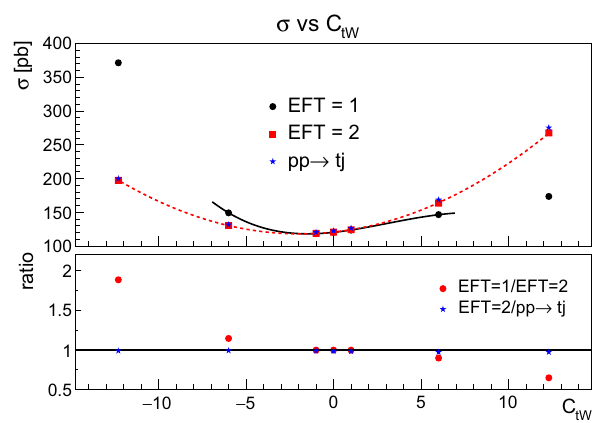
Fig. 9 Comparing the different behaviour of the Wbj cross section with one C tW insertion (EFT = 1) or two C tW insertions (EFT= 2). Both effects have been discussed separately in Figs. 7 and 8. Additionally we show the production cross section ( pp → tj ) which is reproduced by Wbj with two insertions when the right width is taken into